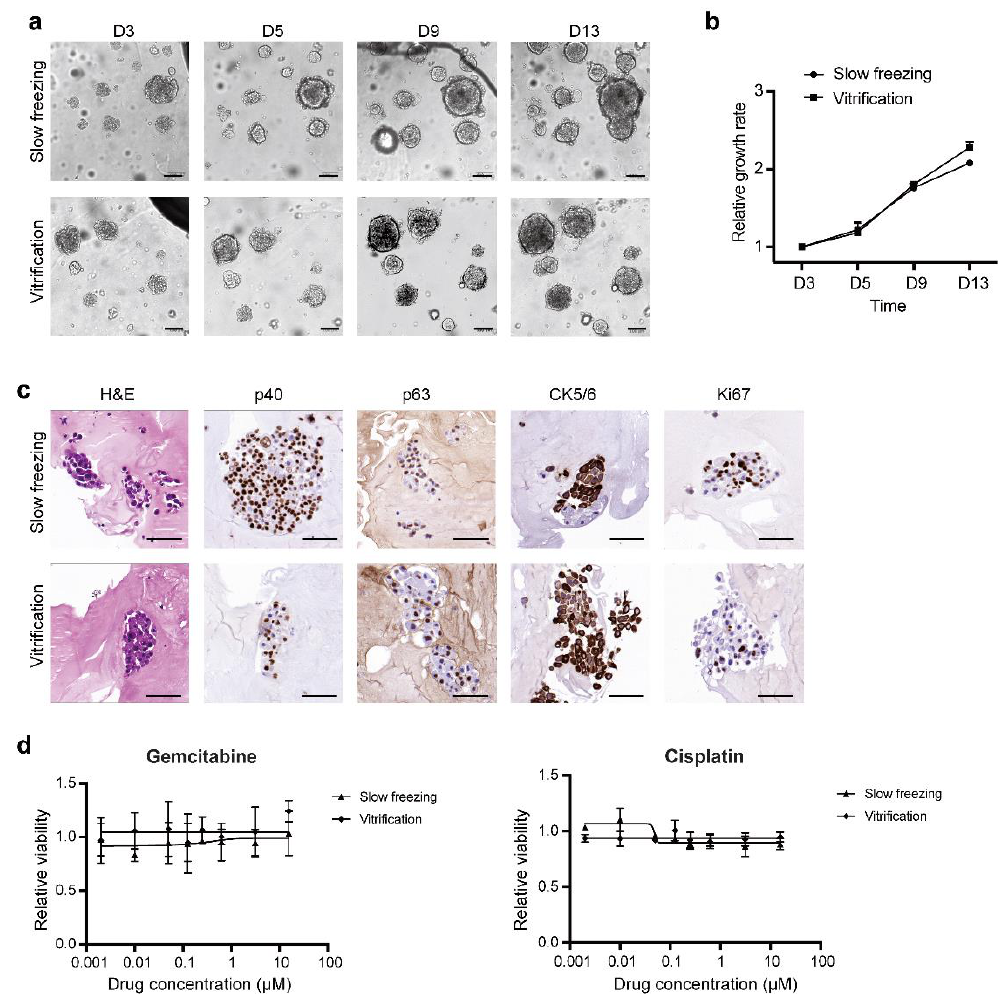
Figure 3. Both the slow freezing and the vitrification methods retained the morphology and cancer marker gene expression. ( a ) Tracing of LCOs thawed from slow freezing and vitrification. The LCOs were cryopreserved using conventional cryovials. ( b ) Growth rates of the LCOs in the slow freezing and the vitrification groups. The growth rates were quantified by measuring the area of the LCOs (data are represented as mean ± SD). ( c ) The histological and immunohistological staining of LCOs in the slow freezing and vitrification groups. ( d ) Drug responses of the LCOs underwent slow freezing and vitrification (data are represented as mean ± SD). Scale bars in ( b , c ): 100 µm.